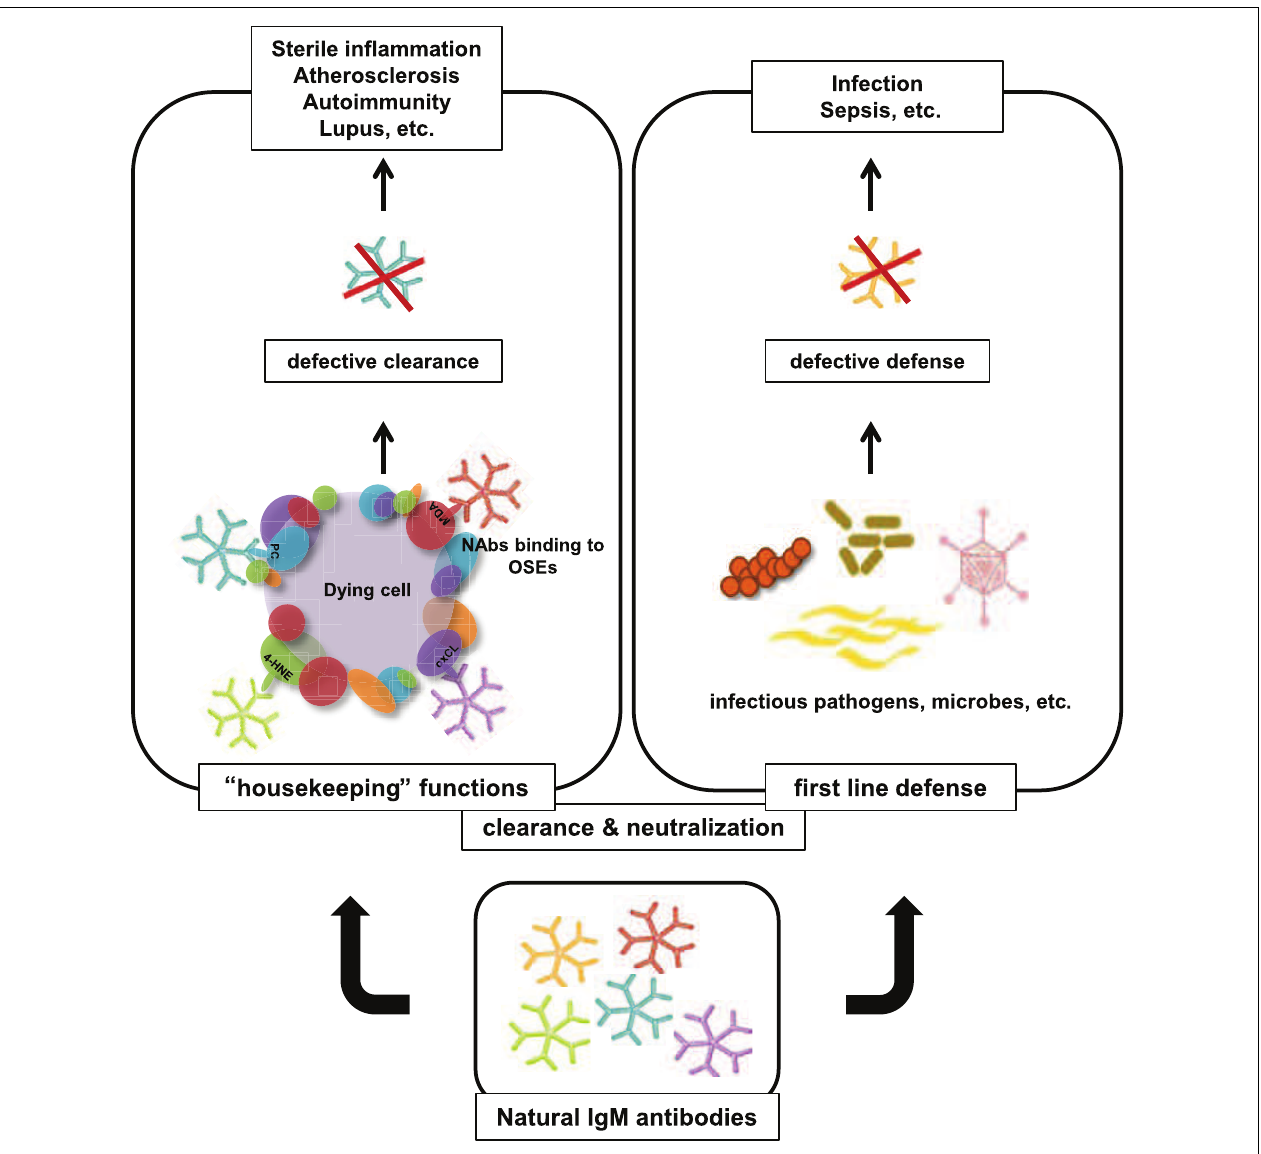
FIGURE 1 | Overview of protective properties of NAbs specific to OSEs. NAbs exhibit housekeeping and host defense functions by targeting OSEs on the surface of apoptotic cells, self antigens, and microbial agents. Insufficient NAbs titers may lead to impaired clearance of cellular debris and reduced protective capacity from invading pathogens. Accumulation of apoptotic material can trigger auto-immune responses and promote chronic inflammatory